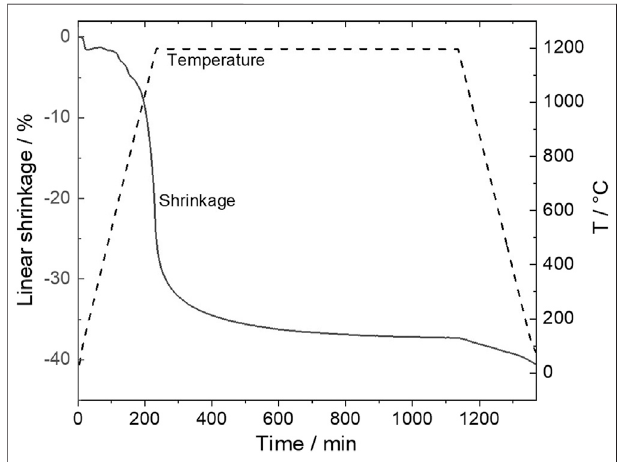
FIGURE 3 | Dilatometry of NNFM/NZSiP mixed material performed in arti fi cial air with a heating rate of 5 K/min from 35 to 1,200 ° C, holding time of 10 h, followed by a cooling down to RT with 5